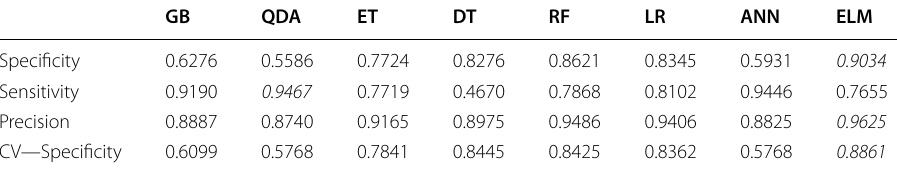
Table 10 Performance scores of individual algorithms and ensemble